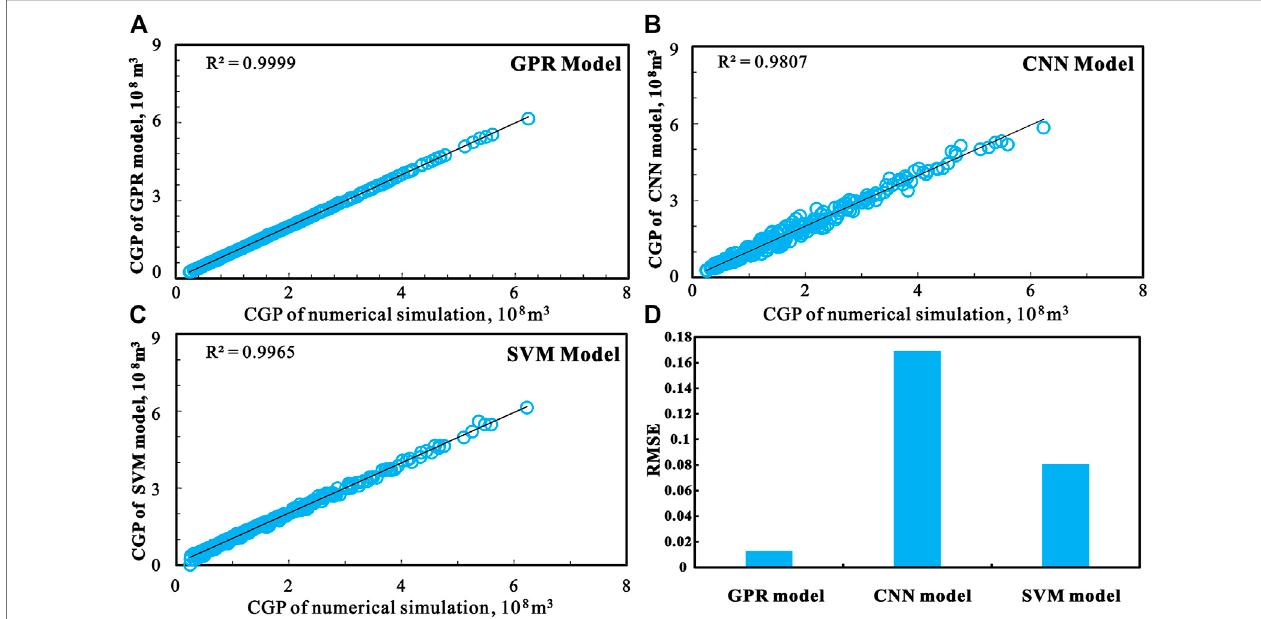
FIGURE 6 | (A) Comparison of production predicted by the GPR model and numerical simulation model. (B) Comparison of production predicted by the CNN model and numerical simulation model. (C) Comparison of production predicted by the SVM model and numerical simulation model. (D) RMSE of GPR model, CNN model and SVM